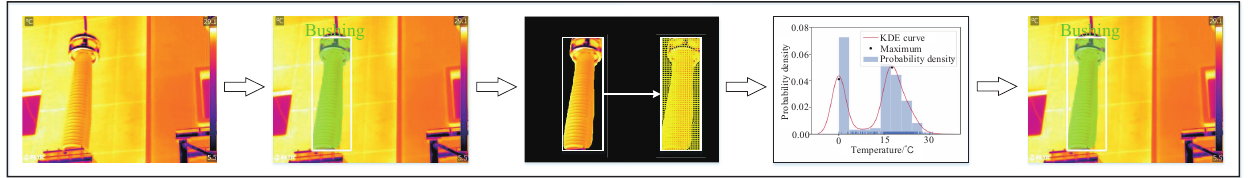
Figure 8. Process of the normal bushing infrared image detection.